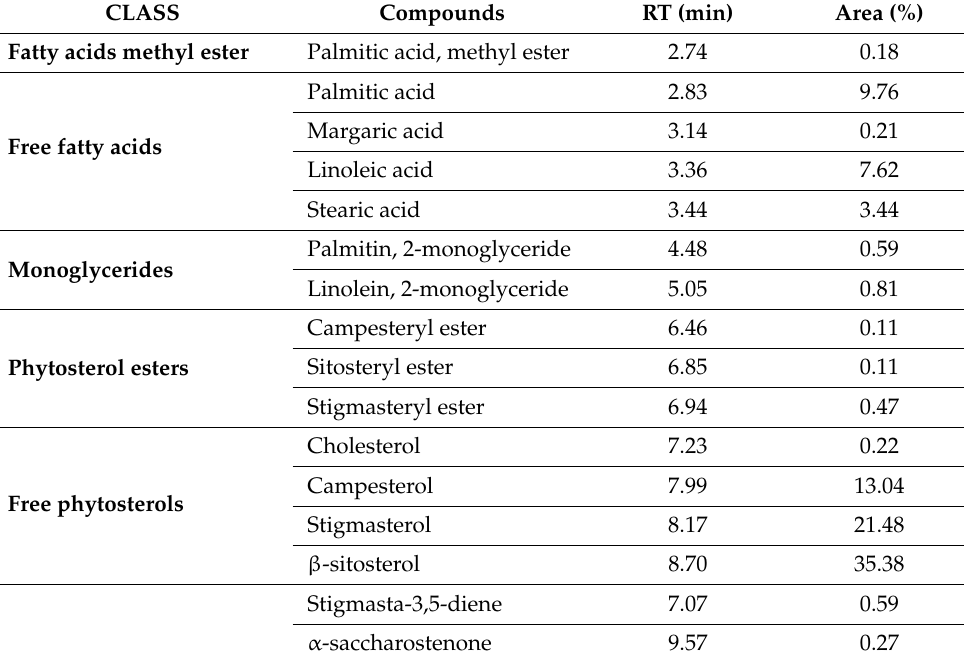
chemical classes. A small amount (0.2%) was annotated as phytosterol esters (Figure 2). Table 1. Chemical profile of n-hexane extract from A. mollis L. rhizomes.